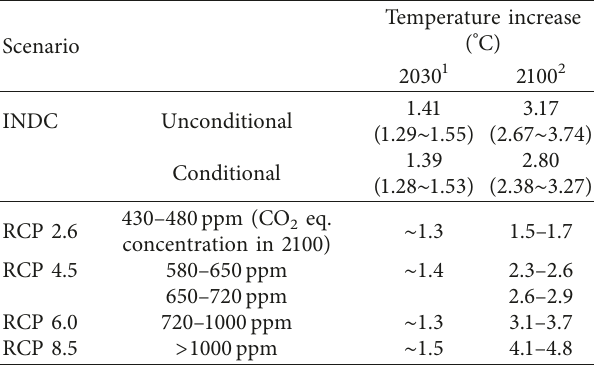
Table 1: Temperature projections for Intended Nationally De- termined Contribution (INDC) and representative concentration pathway (RCP) scenarios (relative to preindustrial levels).